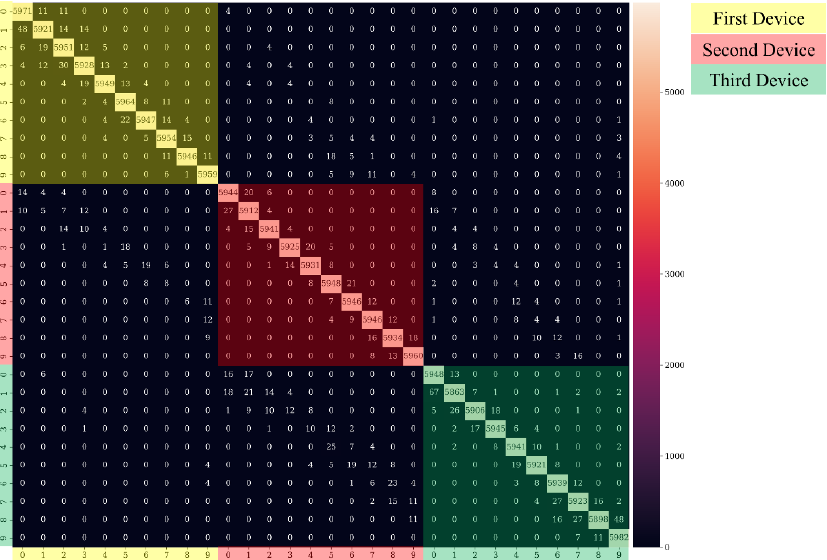
Figure 7. The confusion matrix corresponding to classification performed using a neural network trained on a dataset with 30-component output vectors. The data correspond to ten transmission eigenchannels of three devices with three different scattering strengths N s . This classification allows for identification of both the eigenchannel as well as the disorder strength. The ports corresponding to the respective three devices are color coded. The maximum value in any cell can be 6000.